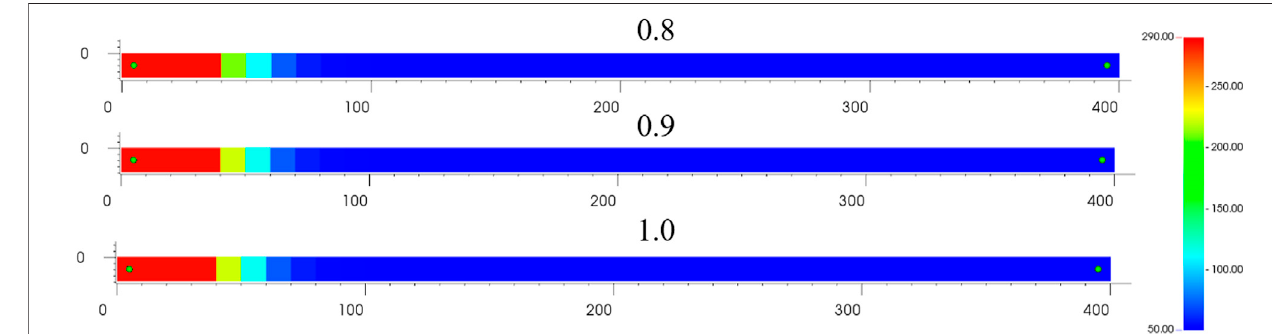
FIGURE 6 | Temperature comparison.